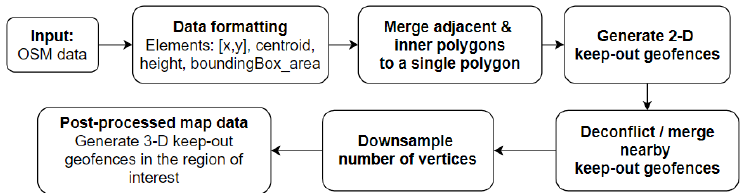
Figure 7. Flowchart of post-processing map data. OSM data were converted to a MATLAB for- mat, then processed using polygon set convex hull operators to reduce the number of keep-out geofences in the region of interest (ROI), the area between departure and destination points. If the number of vertices in a geofence is greater than threshold n maxVert , it is downsampled to p dwnSmple . n maxVert and p dwnSmple are user-defined parameters set to 15 and 60%, respectively, in this work. Algorithms 2 and 3 are used in finding ROI and reducing number of map vertices.